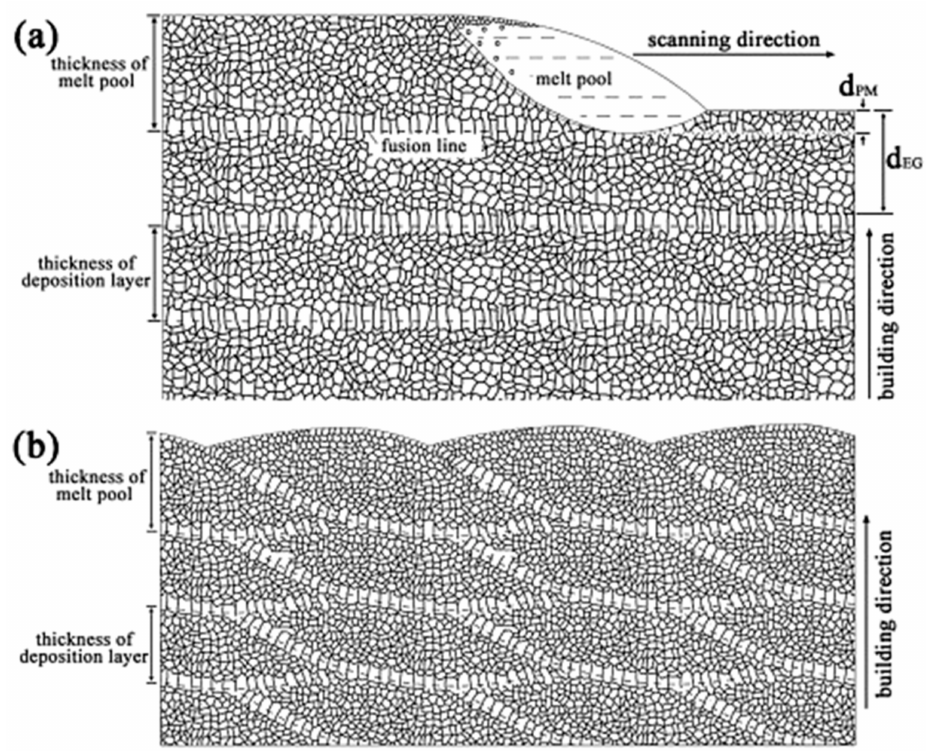
Figure 8. Schematic illustration for the formation of fine near-equiaxed grains for titanium alloy components during the layer-by-layer laser melting in longitudinal ( a ) and transverse ( b ) cross sections (reproduced with permission from [87] Copyright Elsevier,